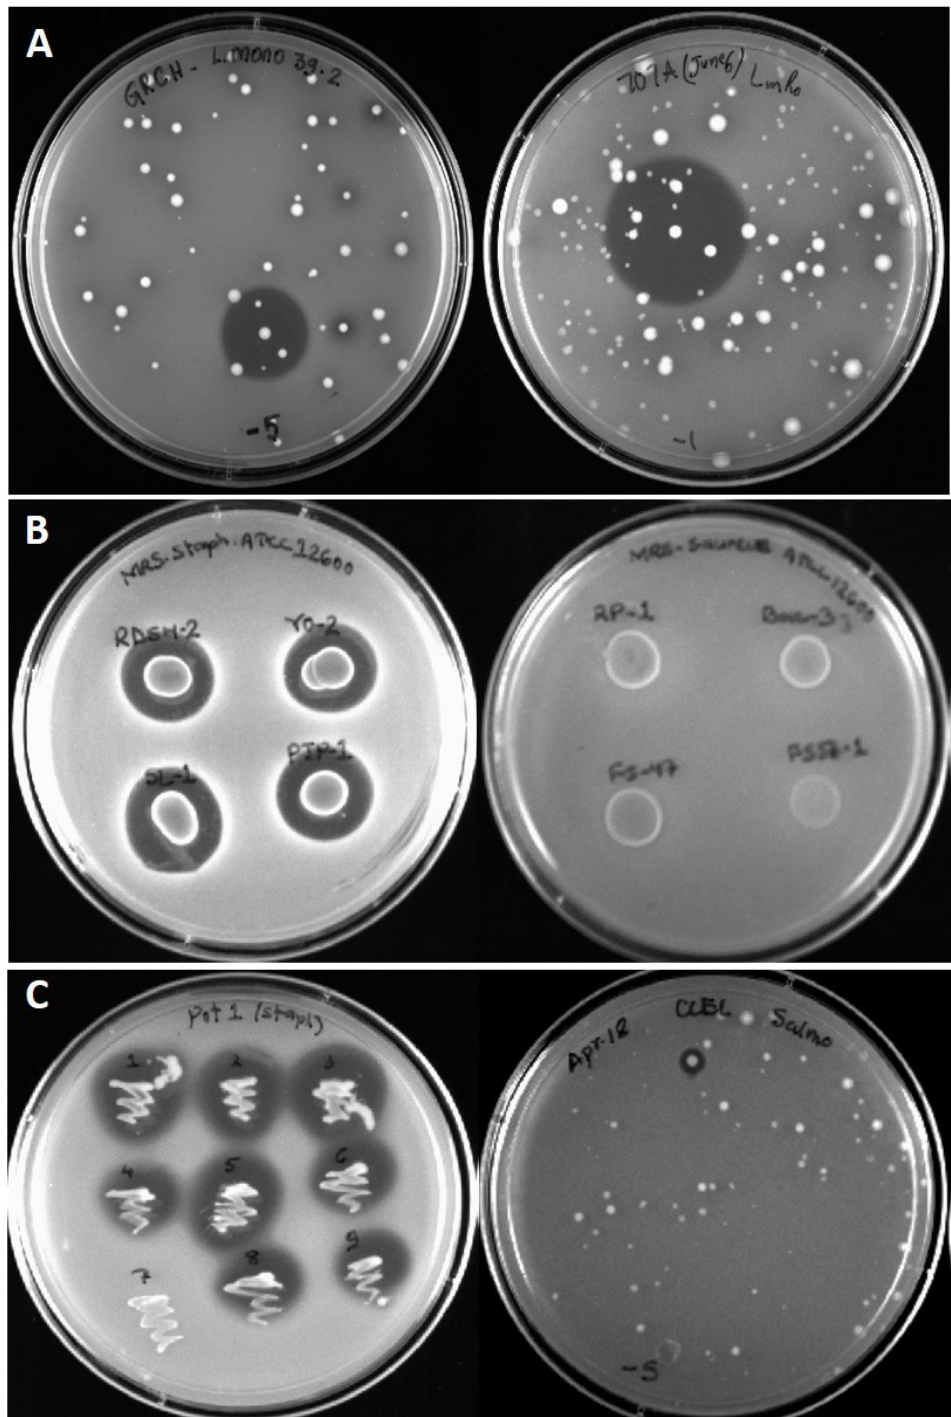
Figure 2. Bacteriocin inhibition zones from overlaid producer colonies, deferred antagonism spots, or patch-plate isolations. Panel A , representative bacteriocin inhibition zones obtained with “sandwich overlay” plates of food enrichment samples overlaid with Listeria monocytogenes 39-2 indicator lawns. Panel B , deferred antagonism assay of culture spots overlaid with Staphylococcus aureus ATCC 12600. Panel C , patch plate of Serratia plymuthica POT-1 (left) overlaid with S. aureus ATCC 12600 and an inhibition zone from Serratia ficaria CCEL-1 (right) against Salmonella Typhimurium H3380 used as a primary indicator